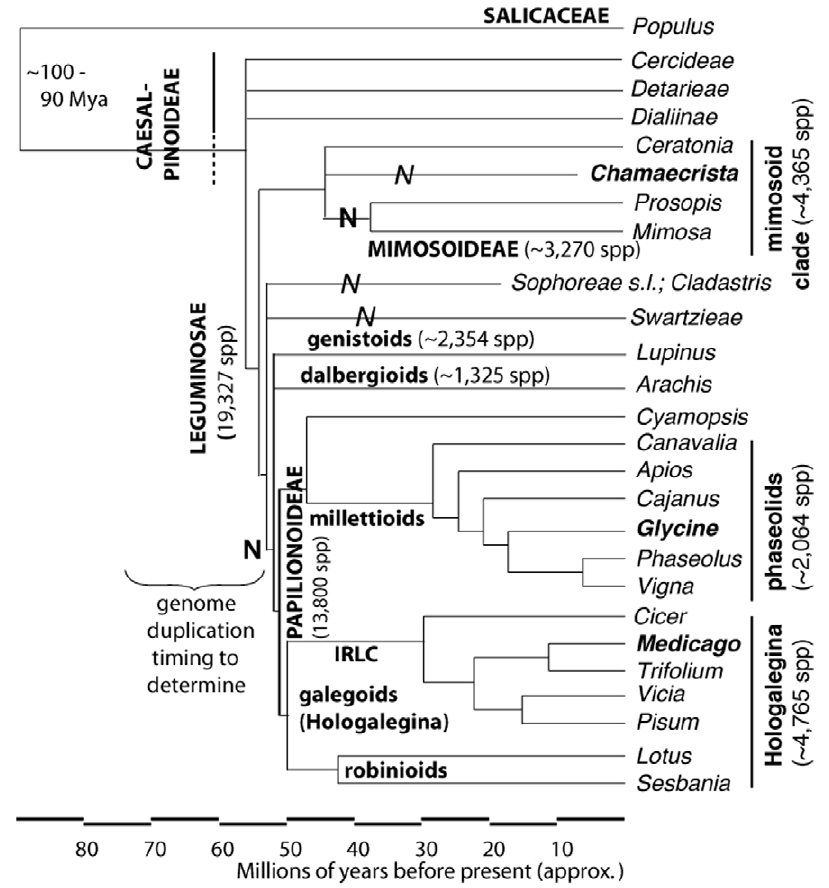
Figure 1. Skeleton phylogeny of the legumes [after 38, 39, 40, 44]. Nodulation in subtended clades is indicated with ‘‘N’’. Clades with italicized ‘‘ N ’’ contain some nodulating species, but also many non-nodulators. Most sampled genera in the Papilionoideae and Mimosoideae nodulate. The dotted vertical line next to Caesalpinoideae indicates that this subfamily is polyphyletic.